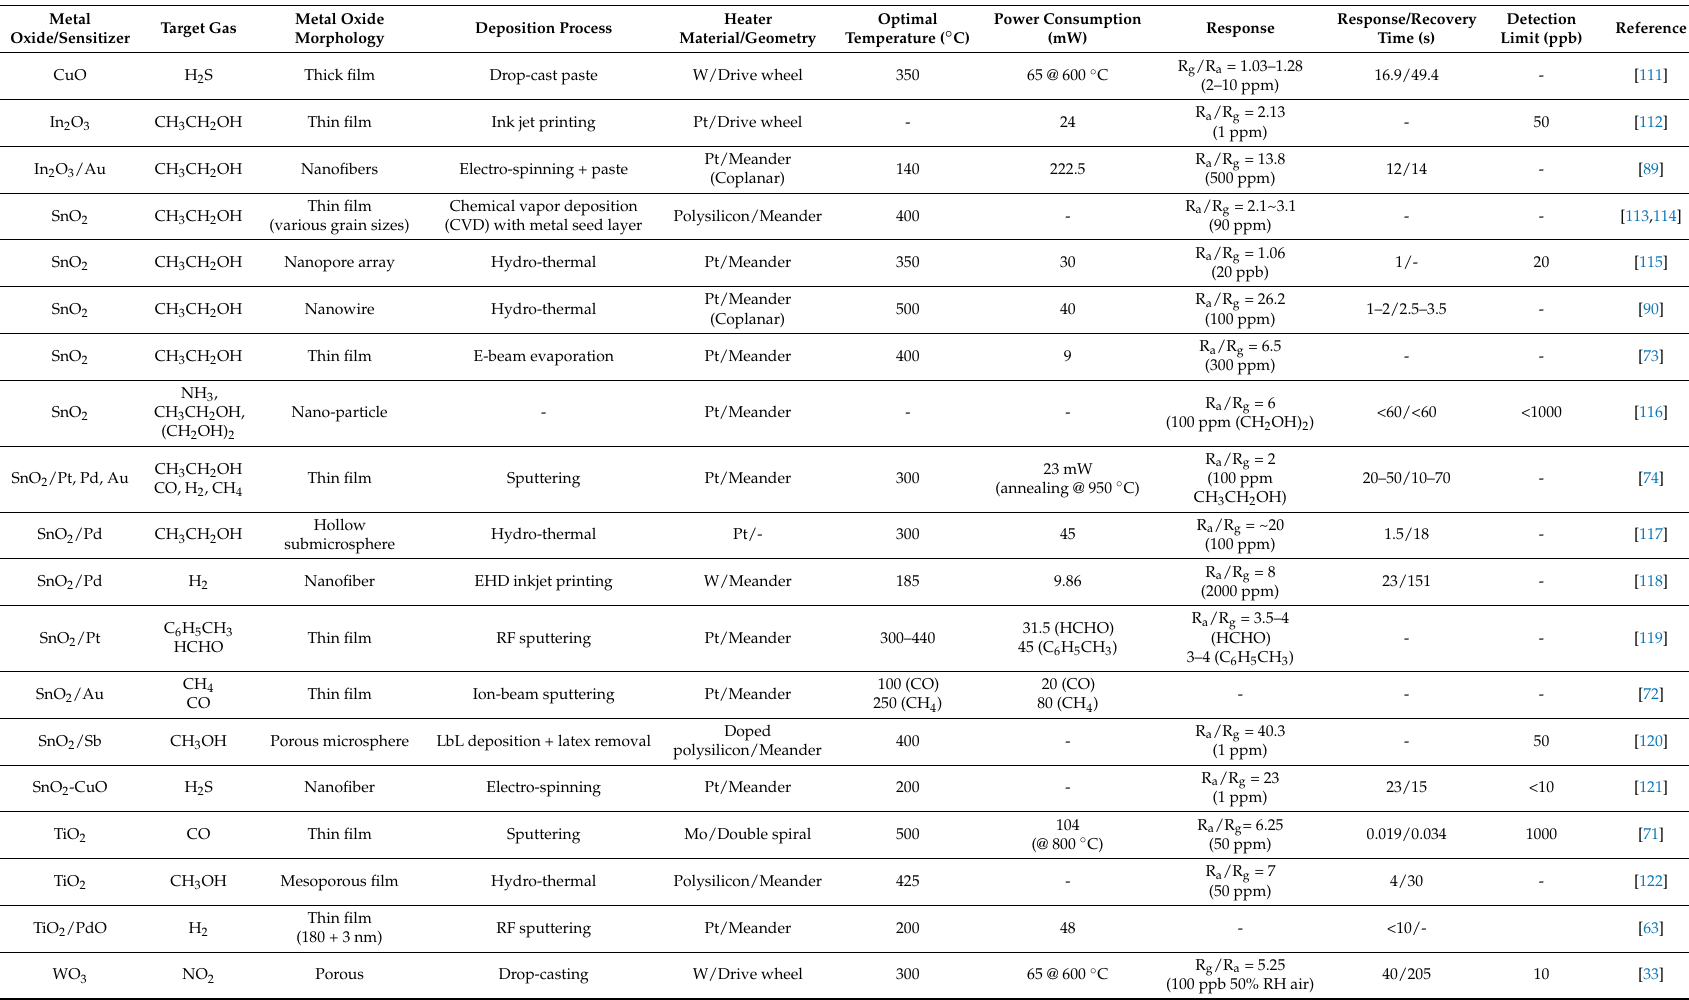
Table 4. Performance of miniaturized metal oxide semiconductor gas sensor